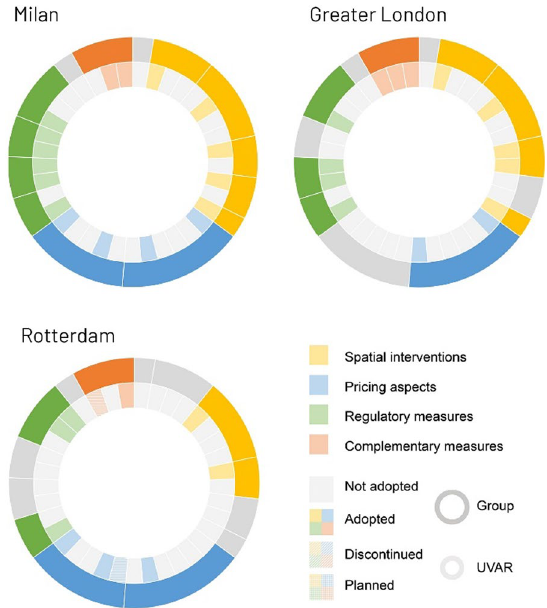
Fig. 11 UVAR measures implemented in the primarily pricing-focused strategies